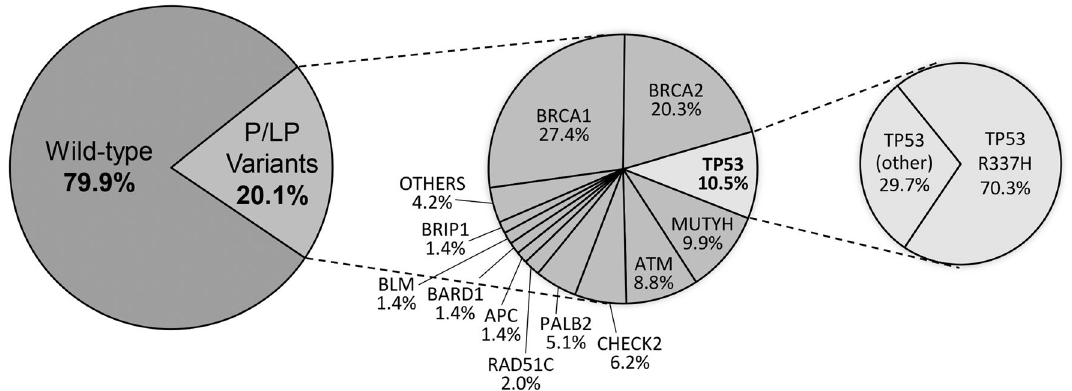
Figure 1. Contribution of TP53 mutation in Brazilian breast cancer patients (n =